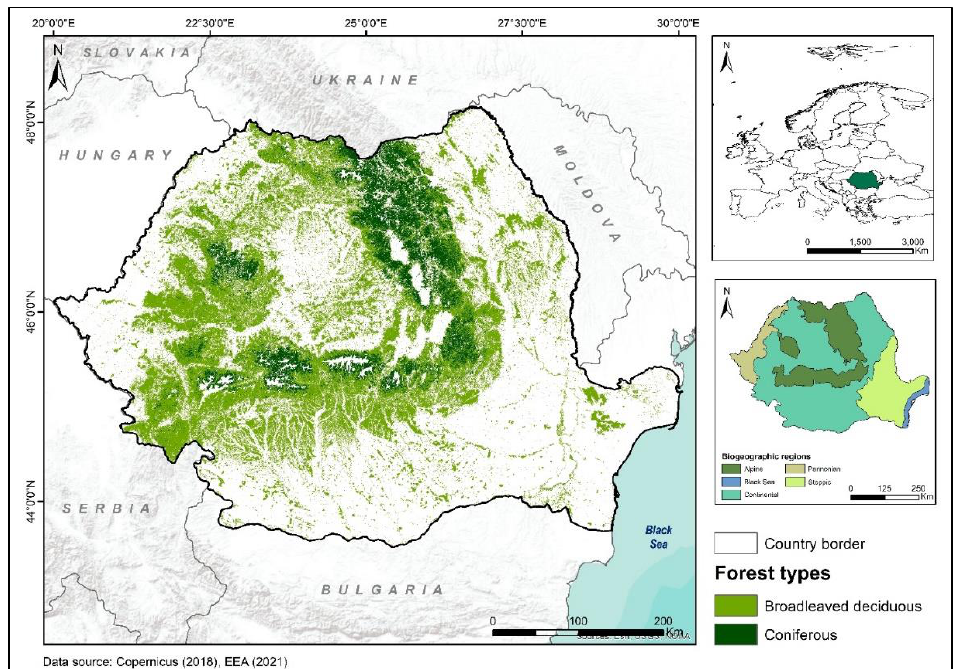
Figure 1. Forest types in Romania (data source: [33,34]). The counties with the most forest are located in the Carpathian Mountain area (e.g., Suceava, Caras -Severin, Hunedoara, Arges , Bac ă u), while the ones with least forest , ,